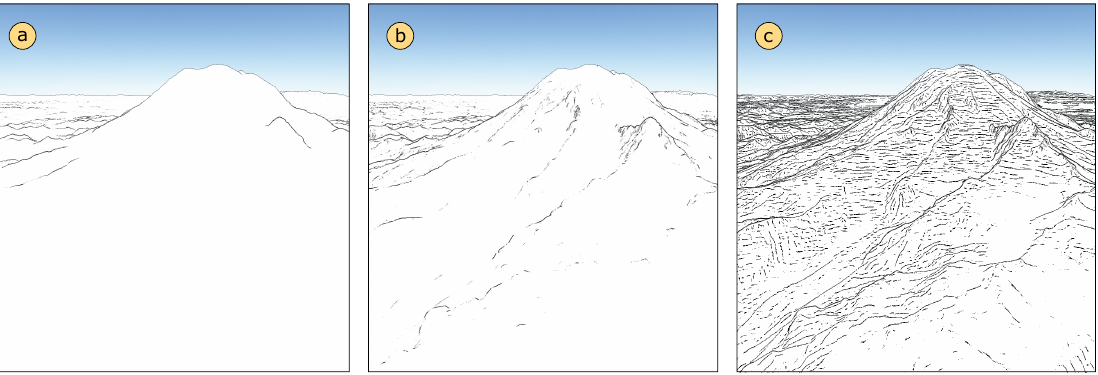
Figure 4. Enhanced edges using line drawing: ( a ) silhouettes are emphasized; ( b ) additional contours along ridges are drawn and ( c ) additional suggestive contours are drawn.